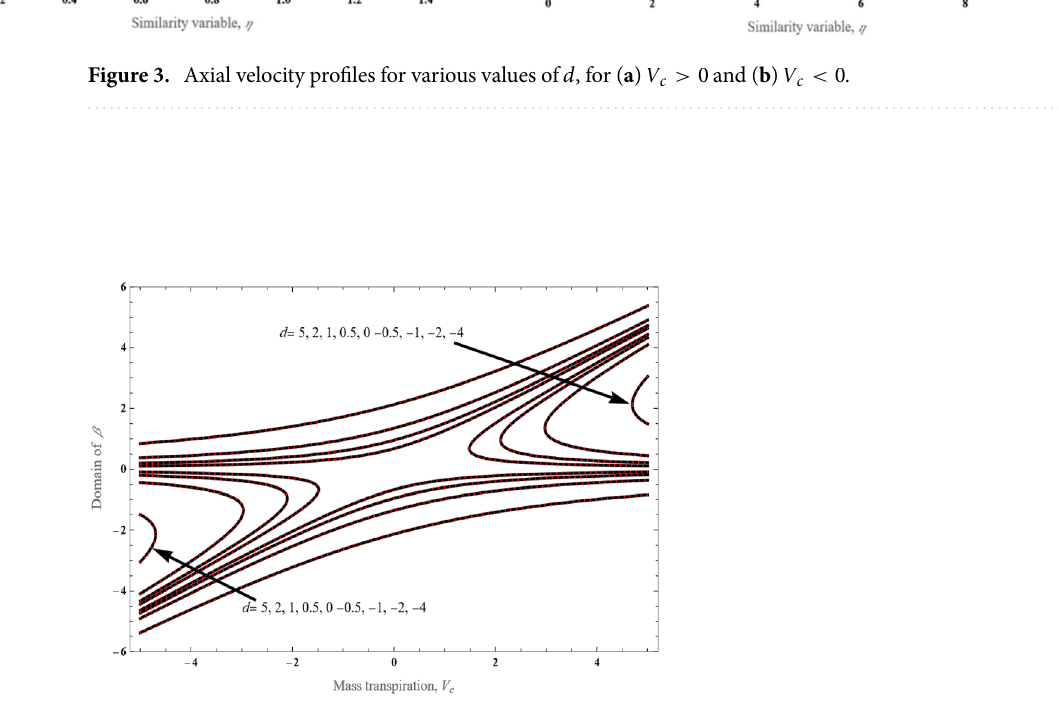
Figure 4. Solution region of β vs. V c for various values of d